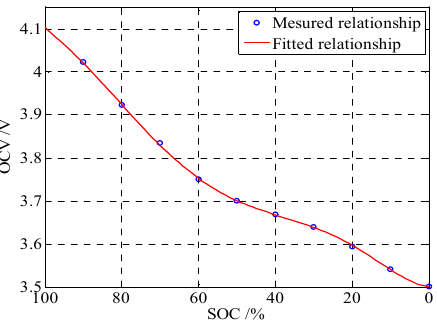
Figure 4. Relationship between OCV and SOC.